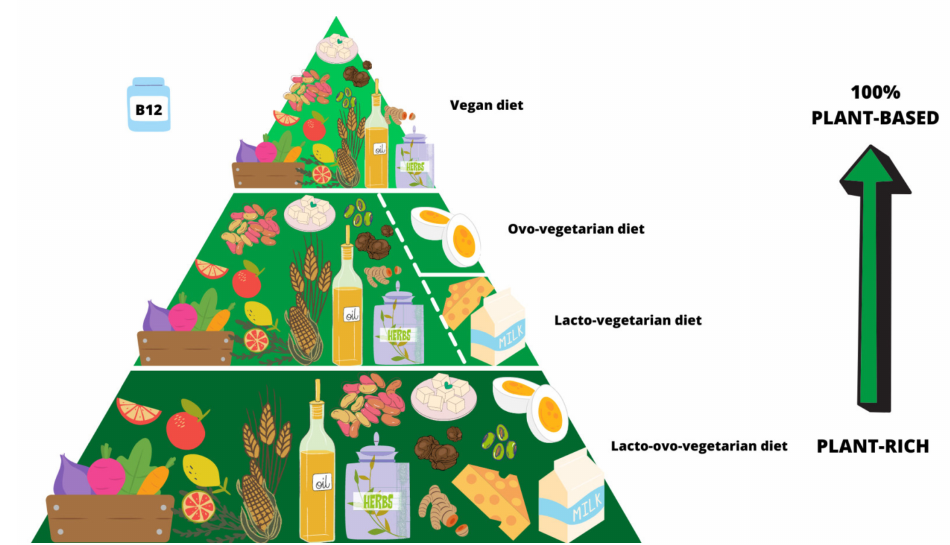
Figure 1. Vegetarian diets: from plant-rich eating patterns (lacto-ovo-vegetarian, lacto-vegetarian, ovo-vegetarian diets) to 100% plant-based (vegan diet). There are no reliable sources of vitamin B12 in plants, so supplementation is